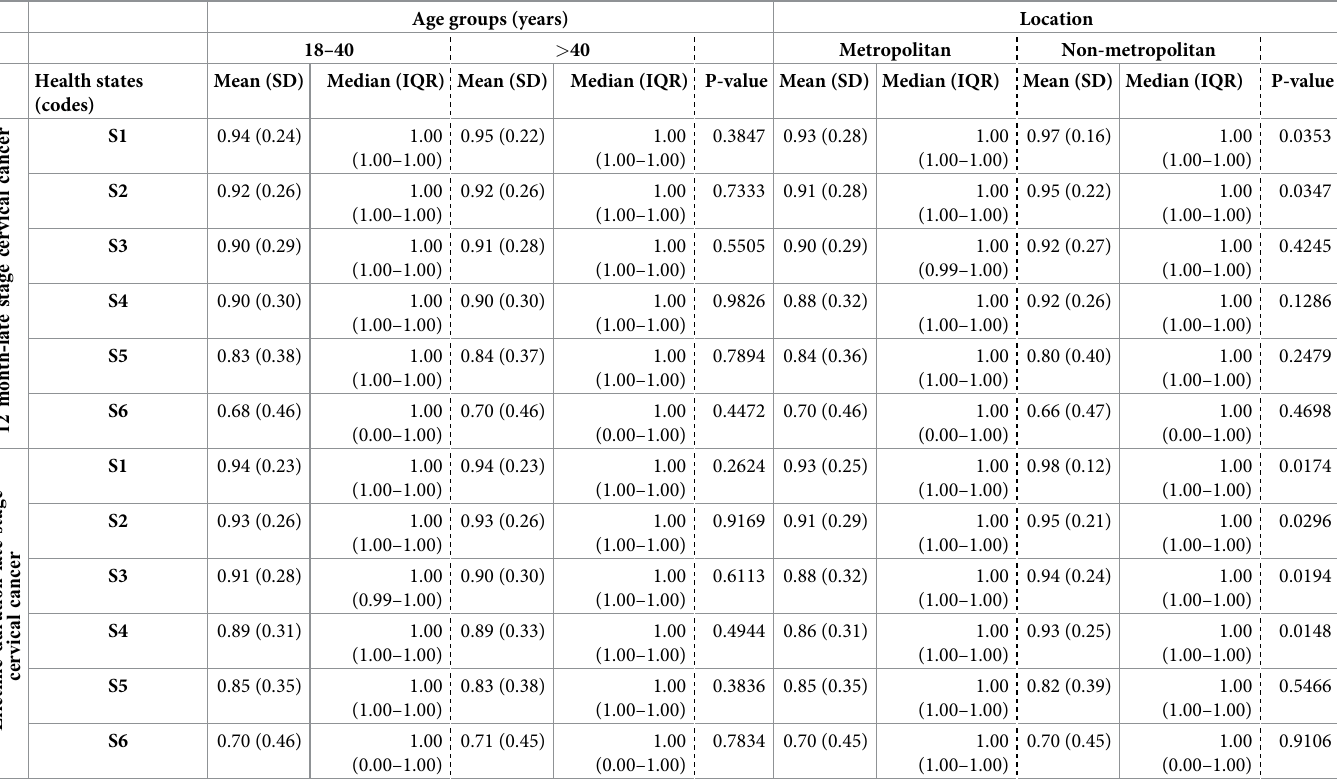
Table 3. Age and residential location comparisons of standard gamble utility scores using the ‘12 month’ and ‘lifetime’ duration later stage cervical cancer. Age groups